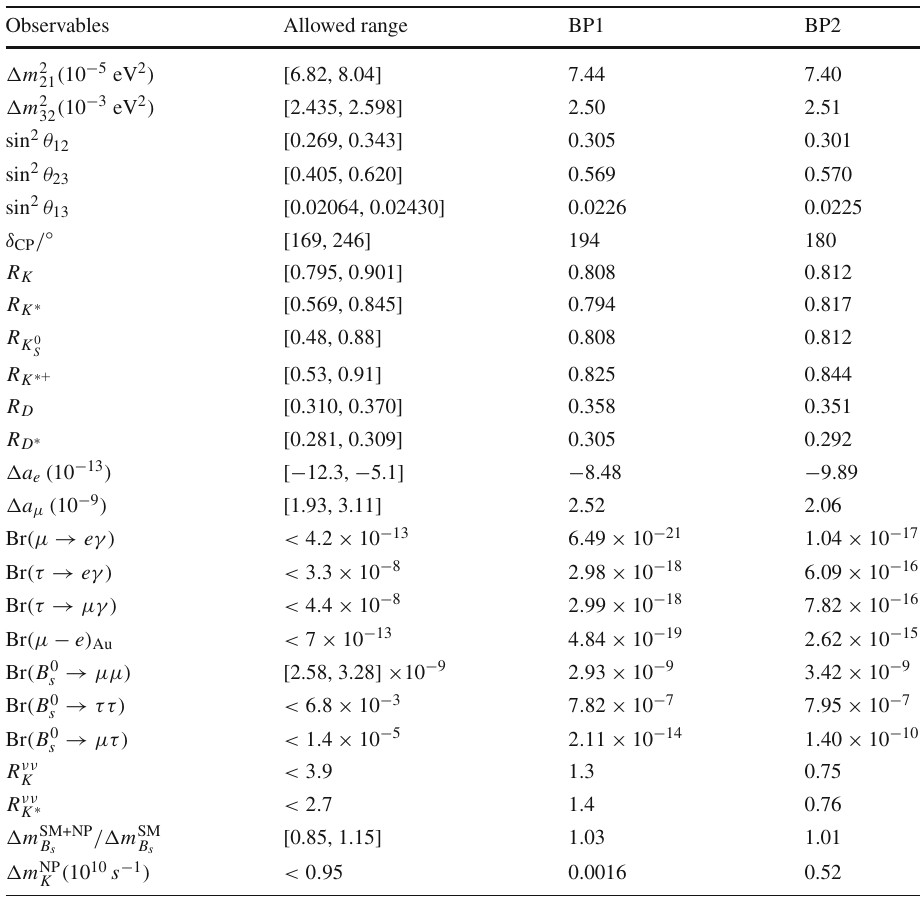
Table 4 Summary of the observable values for the benchmark